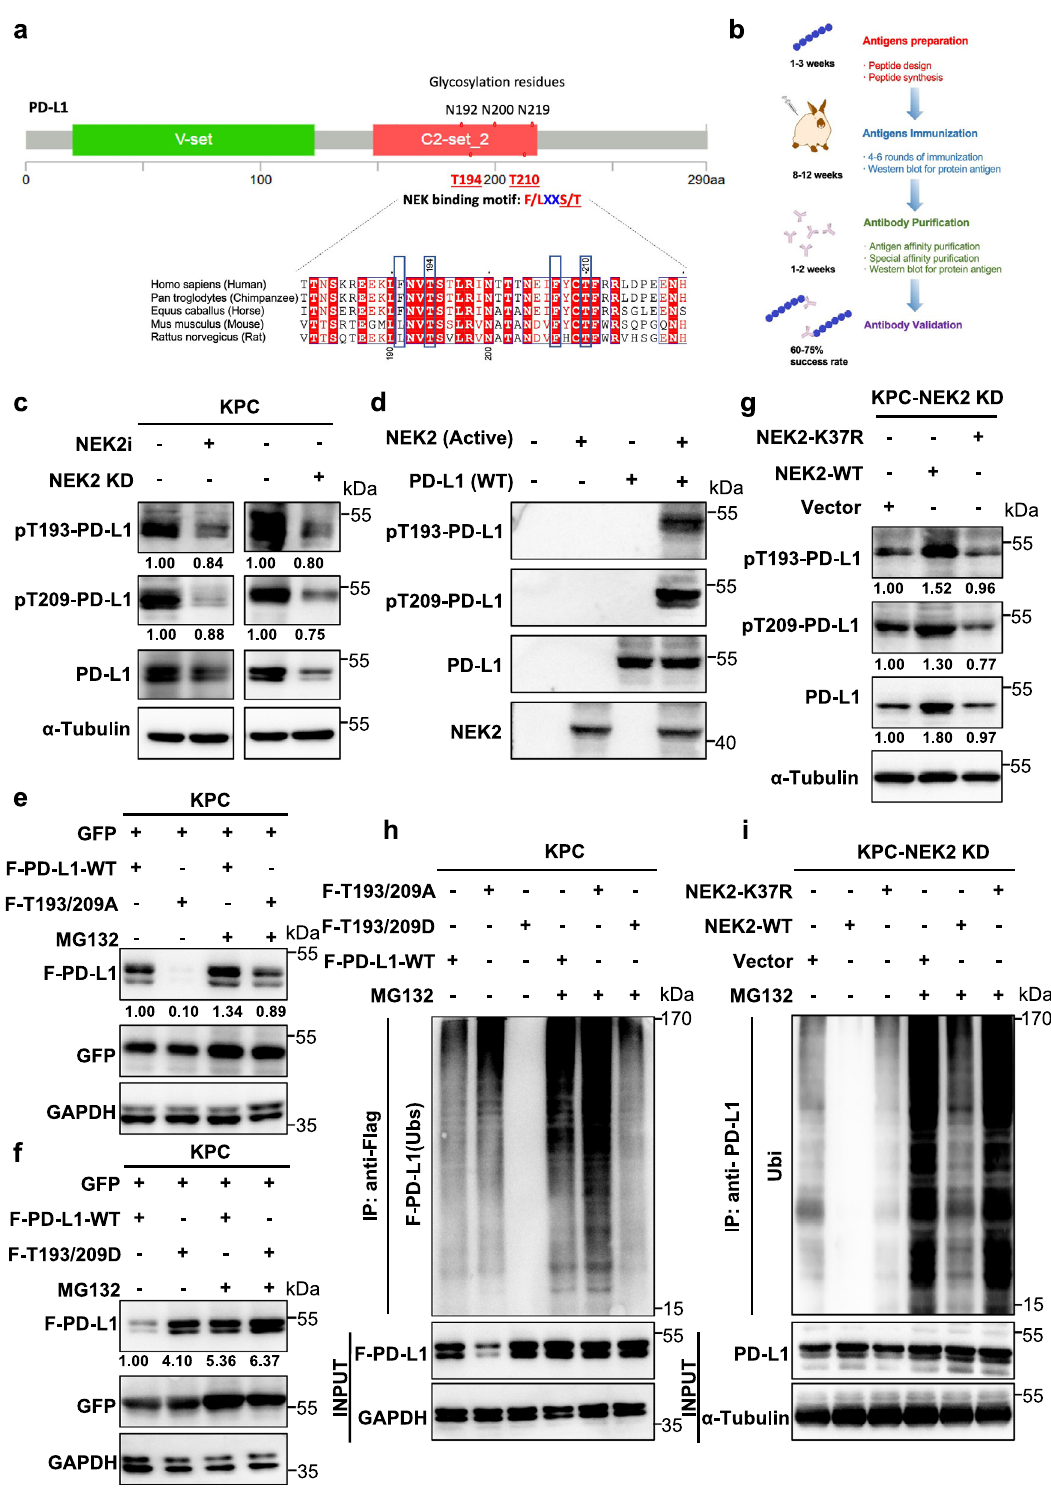
T cell-mediated tumor cell destruction assay . CD8 + T cells were isolated from the mouse spleen using a CD8 + T cell isolation kit, an LS Column, and a MidiMACS ™ Separator. Isolated CD8 + T cells were fl uorescently stained using CD8-PE and CD3- FITC then analyzed using fl ow cytometry to con fi rm their phenotype. KPCs both untreated and treated with NEK2 inhibitor (10 μ M) for 24h were incubated for 48h with activated CD8 + T cells. KPC-NEK2 KD cells and KPC-WT cells were incubated overnight and allowed to adhere to the culture plates, then treated with isolated activated CD8 + T cells and incubated for 48h. KPC cells were incubated overnight to allow adhesion to the culture plates and then treated with isolated activated CD8 +